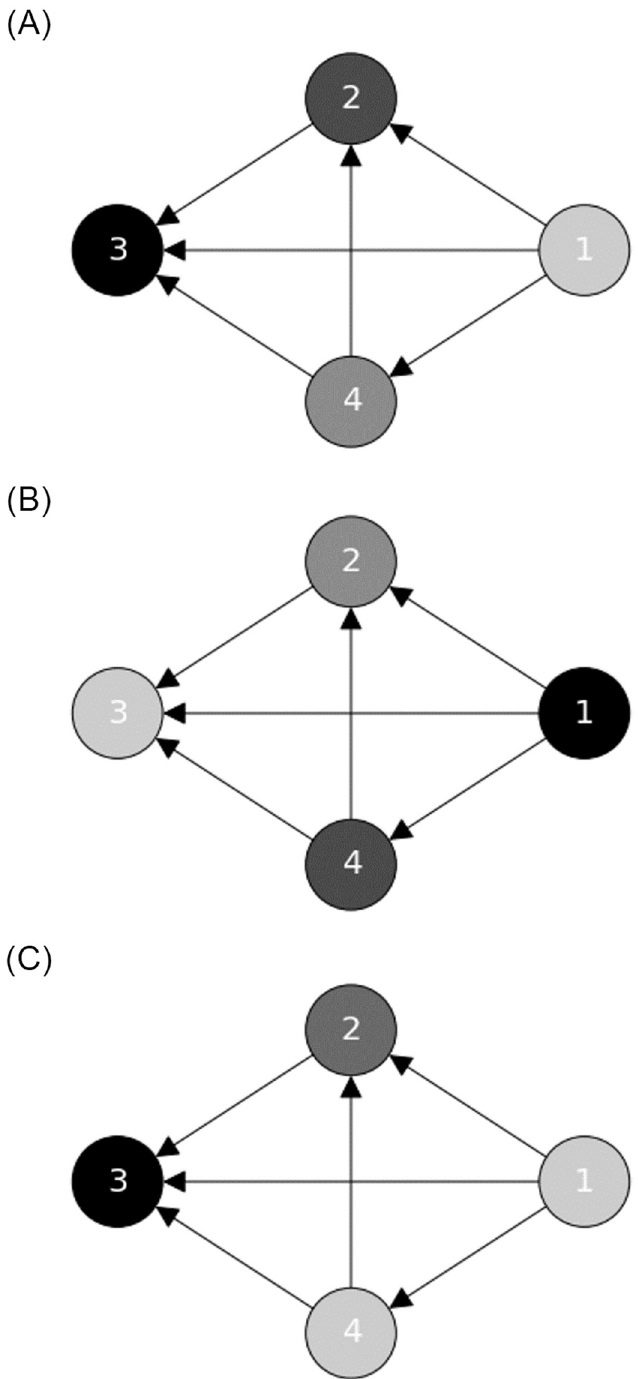
Fig 1. Toy model of the three social capital indicators, where nodes with higher values are colored darker. In this example all link weights are equal to one. (a) Inwards information capital. (b) Outwards information capital. (c) Inwards Favor